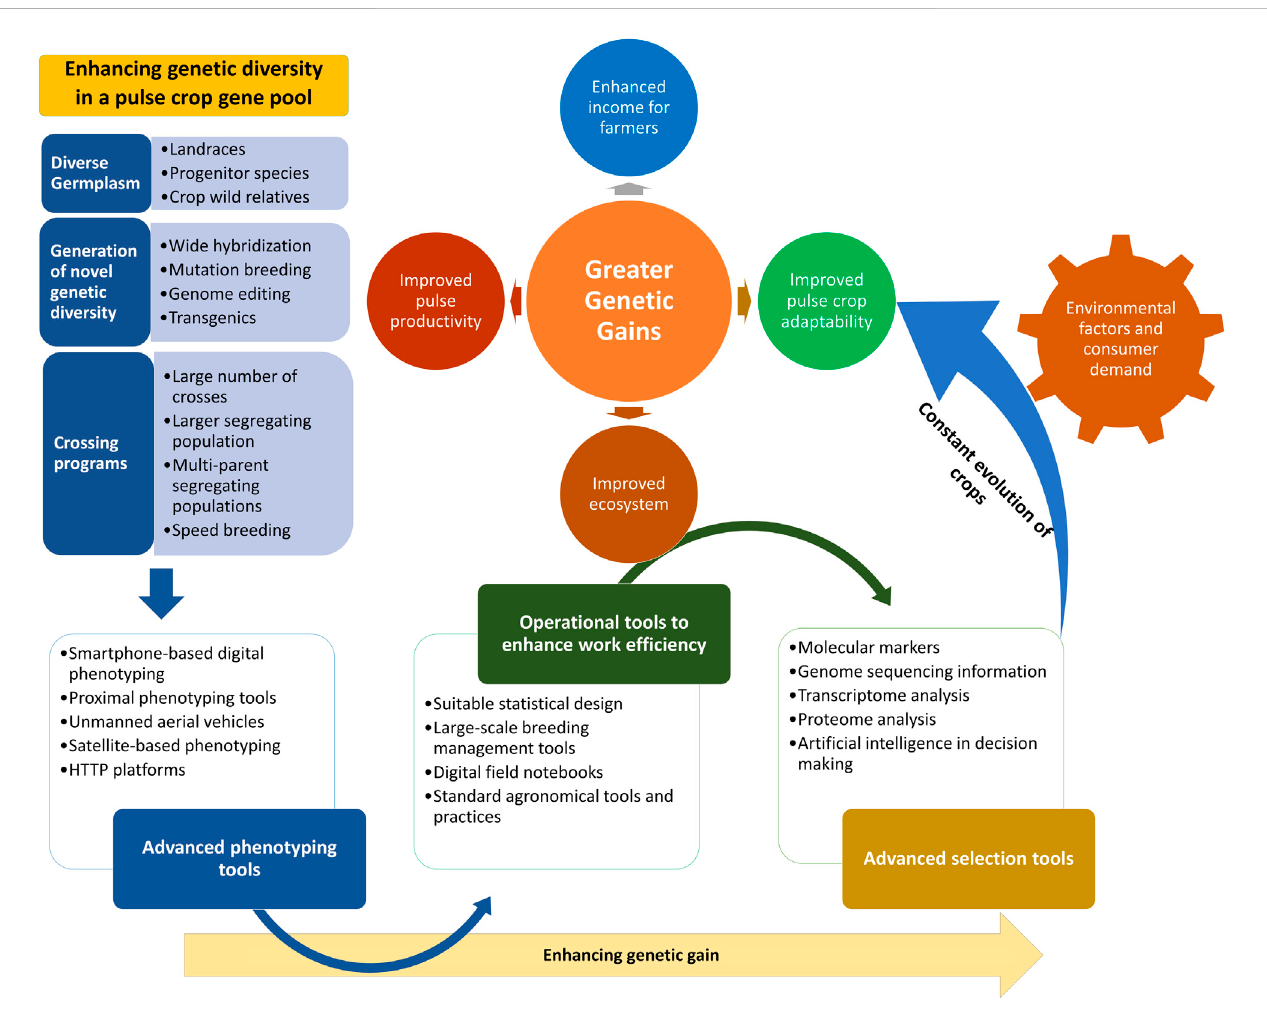
FIGURE 2 Strategy to enhance genetic gains through utilization of advanced phenotyping tools, ef fi cient operational tools, and advanced selection methods and technologies. A strategy to achieve higher genetic gains by broadening the genetic base through the infusion of increasing levels of variability from diverse sources into the target breeding populations is illustrated. The integration of improved crossing program strategies and advanced tools for phenotyping, operations, and desired genotype selection will further enhance the genetic gains made. This strategy will help with the attainment of greater genetic gains along with enhanced crop adaptability to changing climatic